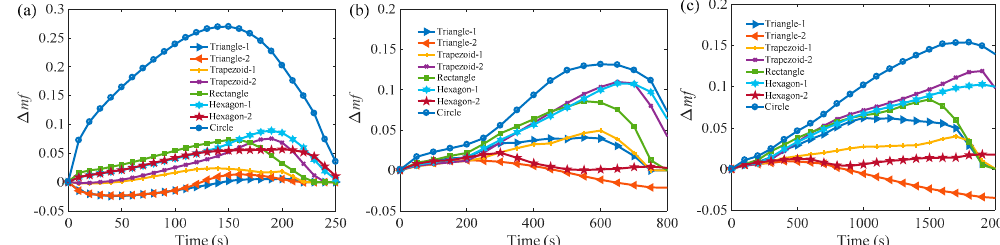
Figure 10. Comparisons of the liquid fraction increase between the cells with the smaller aspect ratio ( AR = 0.5) and those with the larger aspect ratio ( AR = 1.0). ( a ) Ra = 3.095 × 10 5 ; ( b ) Ra = 4.83 × 10 6 ; ( c ) Ra = 3.87 × 10 7 .